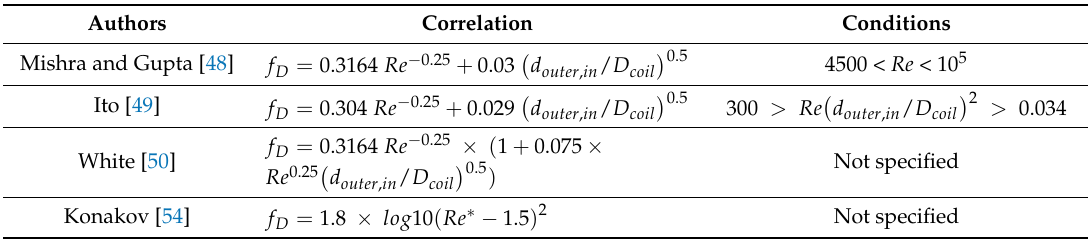
Table 2. Friction factor correlations used in this work.